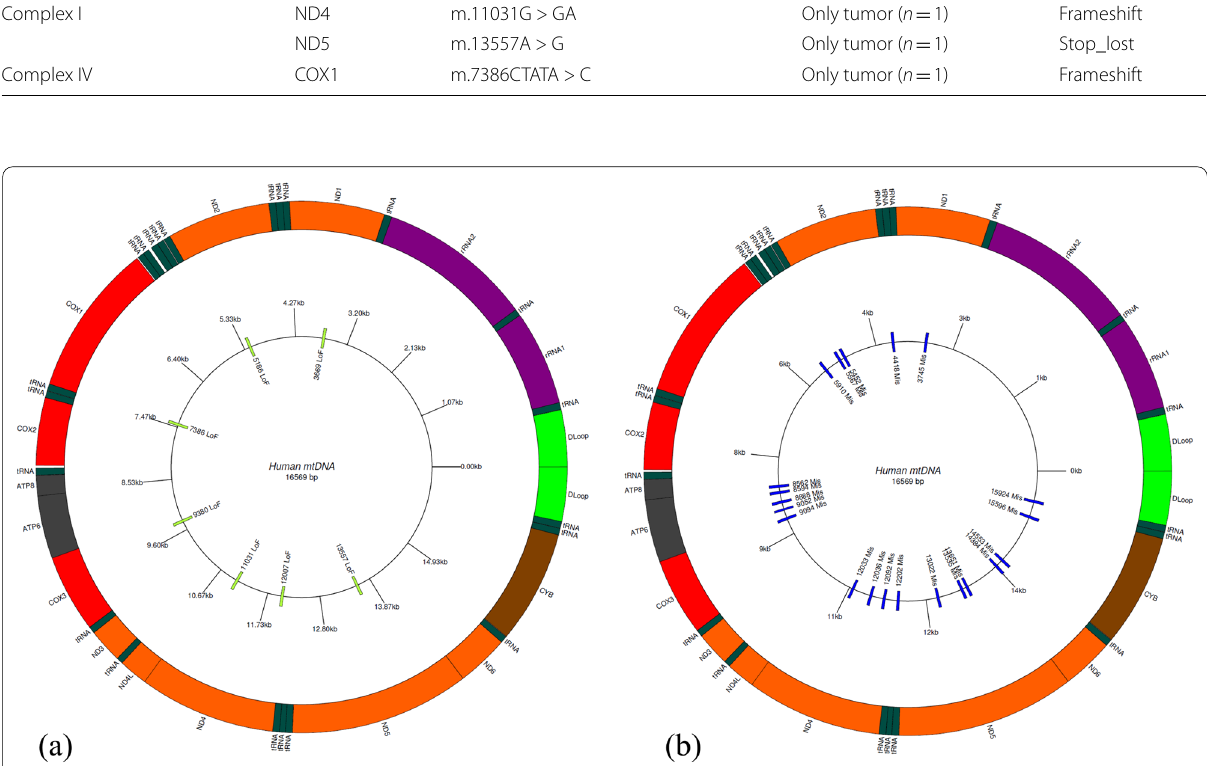
Fig. 2 Circos plot with the outer circle representing the mitochondrial genome of 16,569 bps showing the genes encoding for 13 proteins of ETC complex, 2 ribosomal rRNAs and 22 tRNAs. The inner-circle ( a ) denotes the 7 LOF variants (LOF) in green and ( b ) 21 missense variants (Mis) in